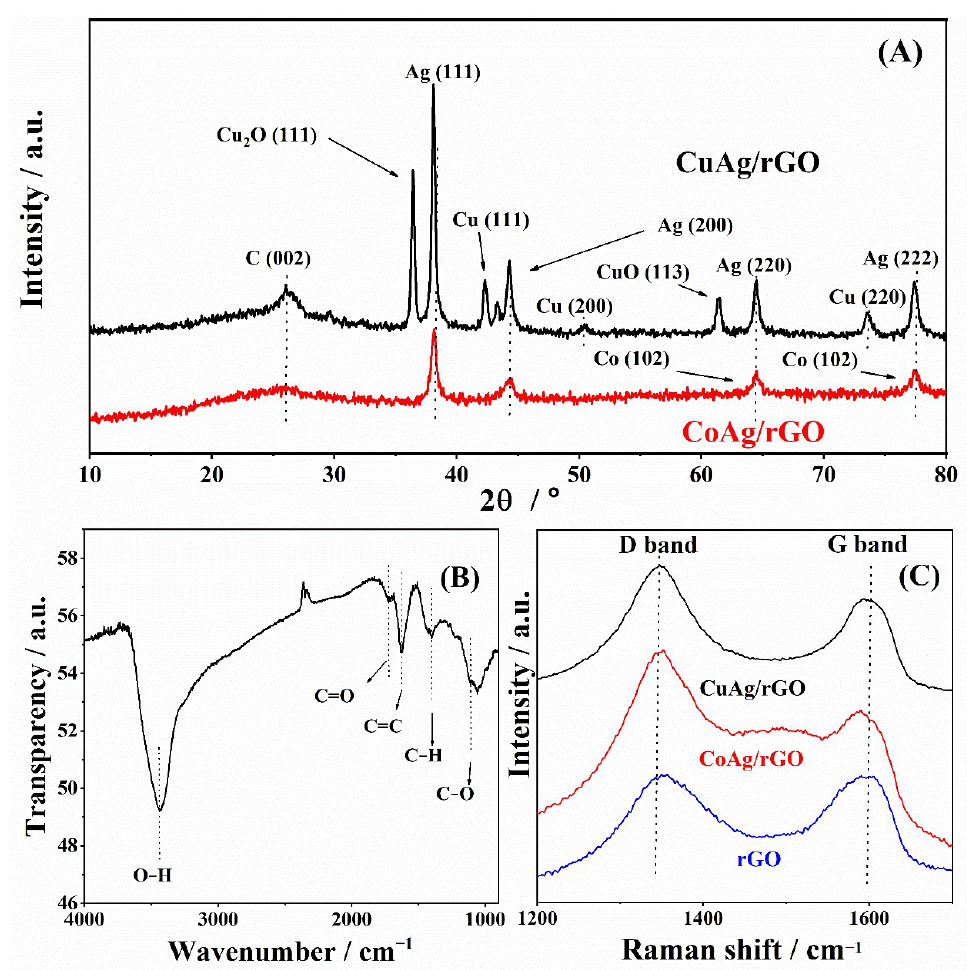
Figure 1. XRD patterns of CuAg/rGO and CoAg/rGO electrocatalysts ( A ). FTIR of rGO ( B ) and Raman spectra of rGO, CuAg/rGO, and CoAg/rGO electrocatalysts ( C ). The FTIR spectrum of rGO is presented in Figure 1B, where a broad peak was noticed at 3438 cm −1 , corresponding to the OH − groups of water adsorbed on rGO [45,46]. The adsorption peaks at 1724, 1623, and 1103 cm −1 were visible for the characteristic carboxyl group C=O, an aromatic C=C group, and a C–O group, respectively [45,46]. The Raman spectra of rGO, CuAg/rGO, and CoAg/rGO (Figure 1C) show two char- acteristic strong peaks, known as D and G bands, at 1351 and 1595 cm −1 for rGO, at 1346 and 1591 cm −1 for CuAg/rGO, and at 1350 and 1596 cm −1 for CoAg/rGO [45]. The G band corresponds to the bond extending of all pairs of sp 2 atoms, whereas the D band represents the presence of structural defects, crystal imperfections, and the measure of the degree of disorder of carbon-based materials [45,46]. The 2D called G’ band characteristic for graph- ite materials was noticed at 2704 cm −1 [45,47,48]. The D + G peak also related to disorder